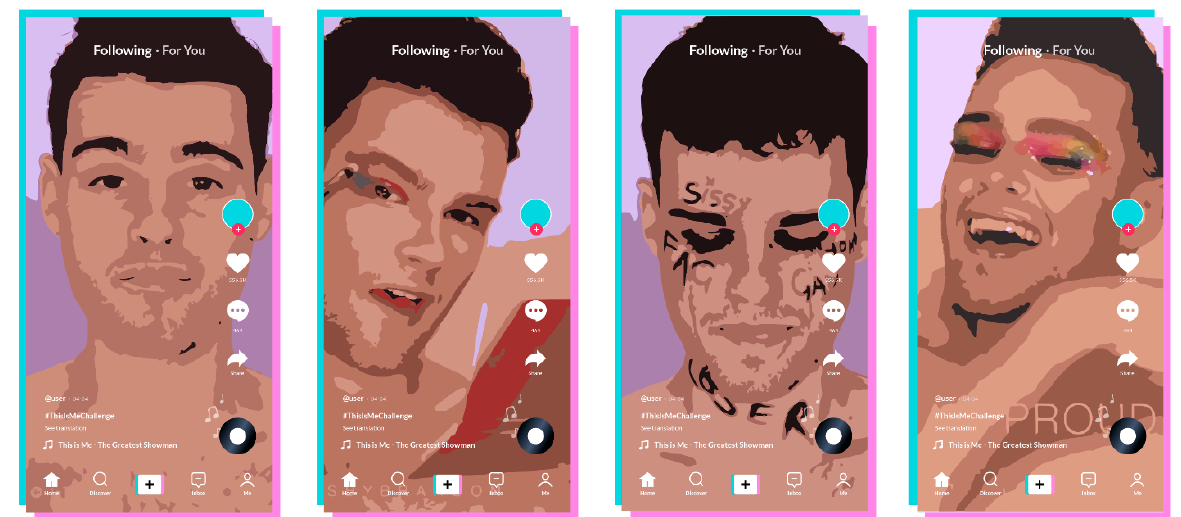
Figure 3. Main stages of #ThisIsMeChallenge. From left to right: TikTokers appearing in front of the camera in a close‐up shot; singing the song as they make‐up through several transitions; covering their face with negative words; appearing in colorful make‐up, smiling, and singing happily.